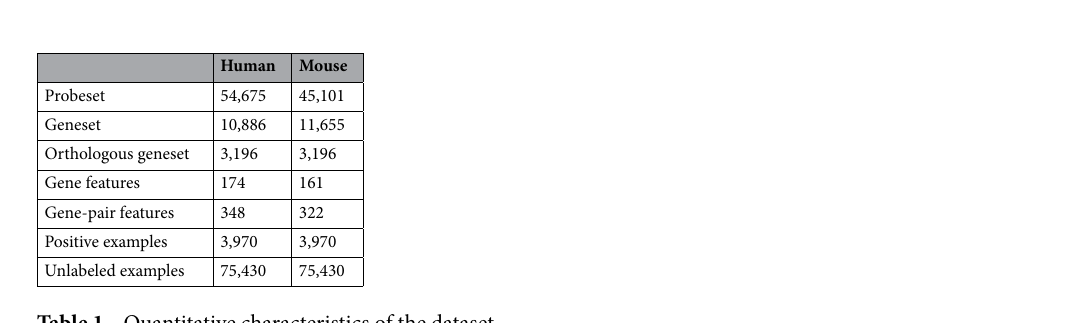
Table 1. Quantitative characteristics of the dataset.